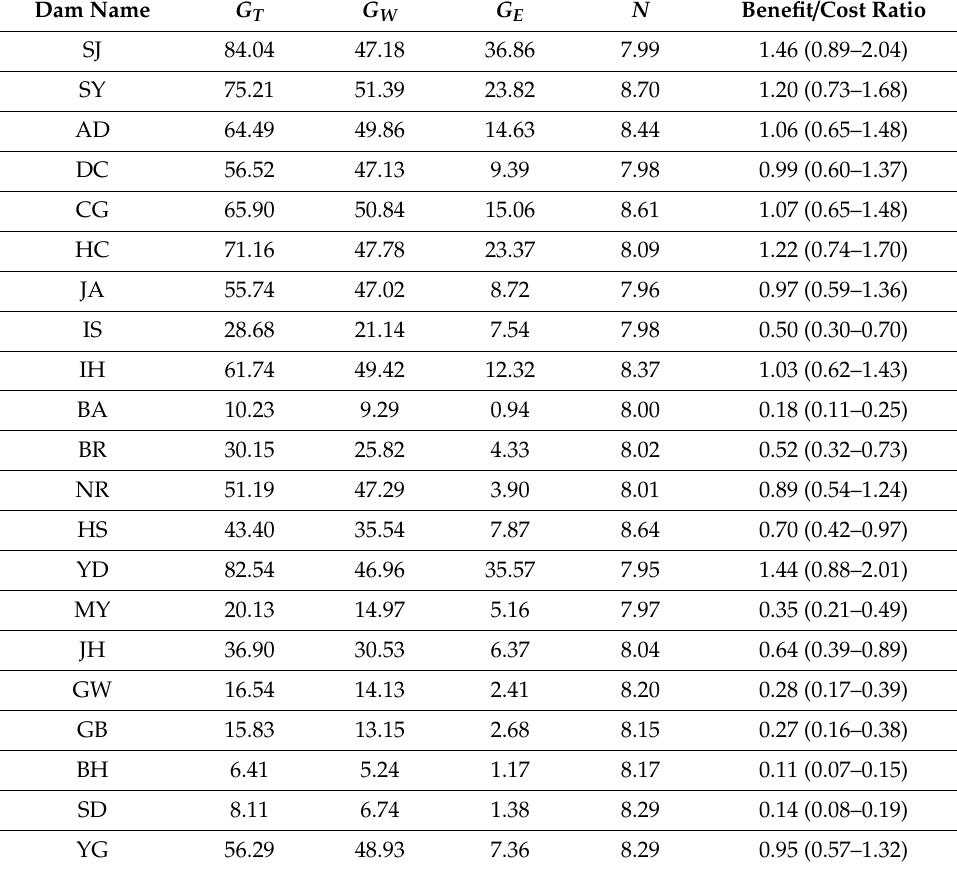
Table 3. Benefits from sale of water ( G W , thousand USD) and electricity ( G E , thousand USD) based on mean monthly increase from precipitation enhancement operations ( N ) in 21 multipurpose dam area, total benefit ( G T , thousand USD), and benefit / cost ratio. The figures in parentheses are the 90% confidence intervals of the benefit / cost